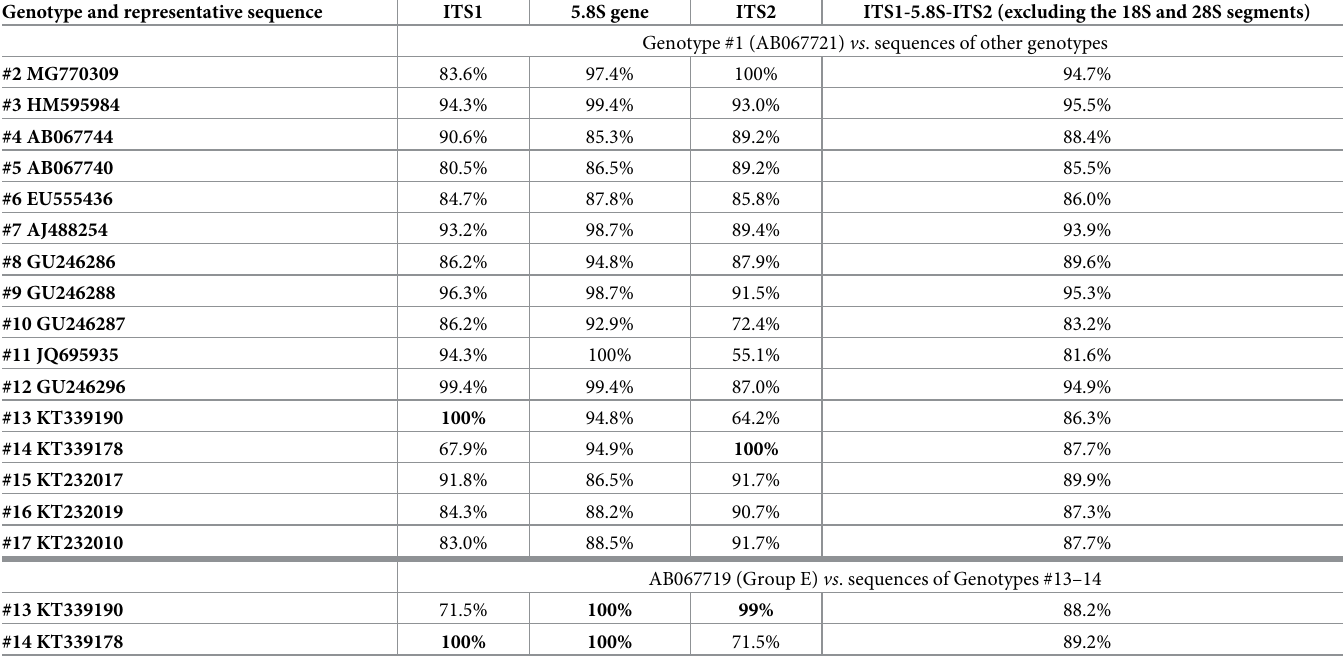
Table 3. Sequence similarities of the ITS1, 5.8S and ITS2 segments of Genotype #1 and AB067719-type sequences compared with the multiple genotypes of O . sinensis